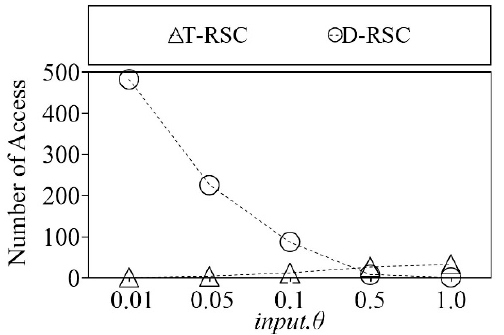
Figure 17. Comparison of number of cluster accesses on real dataset.